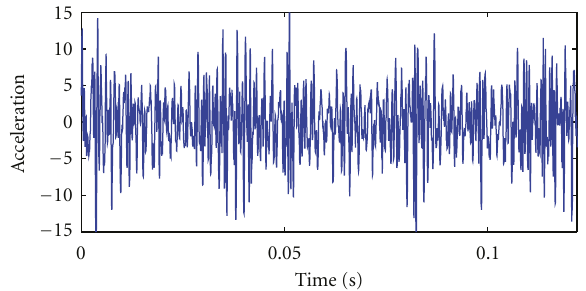
Figure 5: Acceleration measured during 5-shaft revolutions.